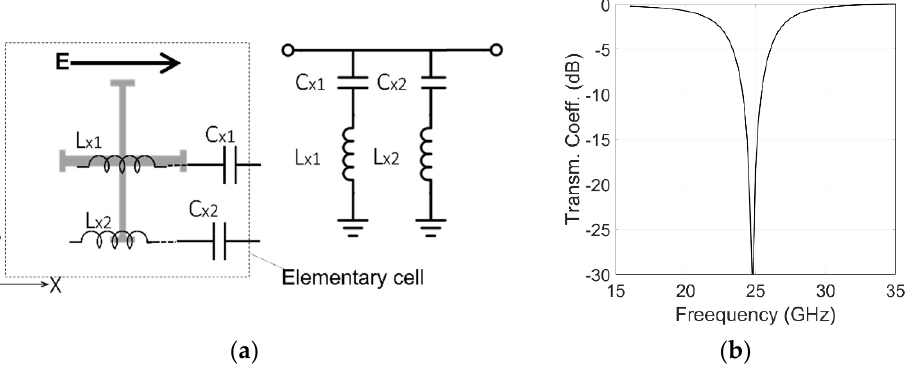
Figure 2. Equivalent circuit model of the Jerusalem cross for an x- polarized impinging wave. ( a ) Equivalent circuit; ( b ) transmission coefficient with Cx1 = 6.4 fF, Lx1 = 6.1 nH, Cx2 = 2.3 fF, Lx2 = 4.8 nH.